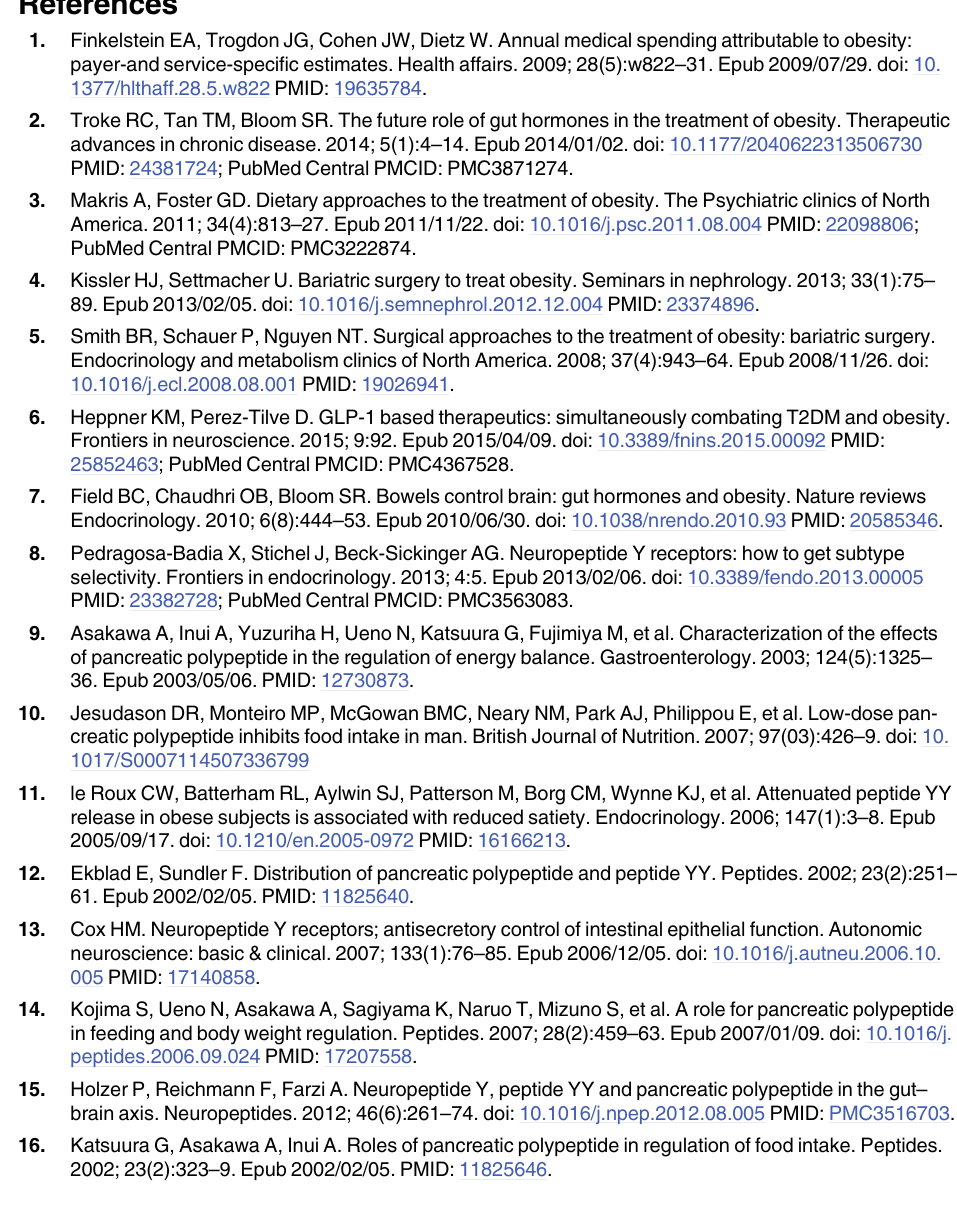
S1 Table. Substructure search: Niclosamide analogues and